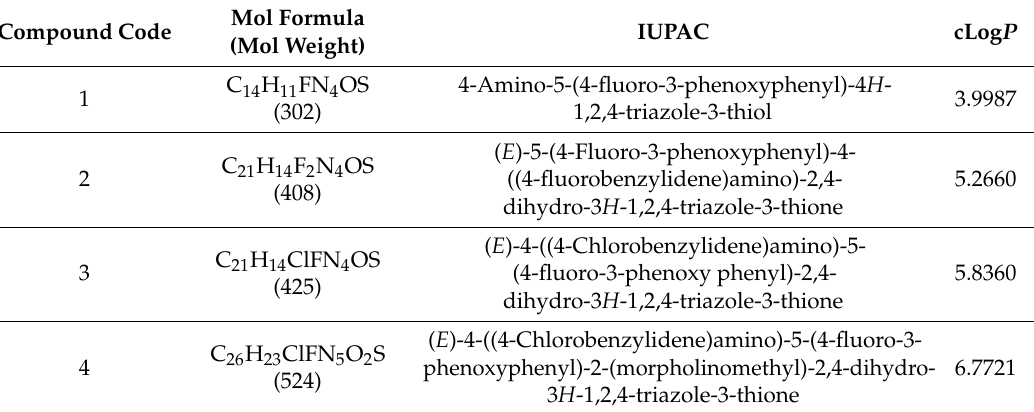
Table 2. IUPAC and cLog P of the title compounds used for whole-cell anti-TB screening against H37Rv and MDR strains of